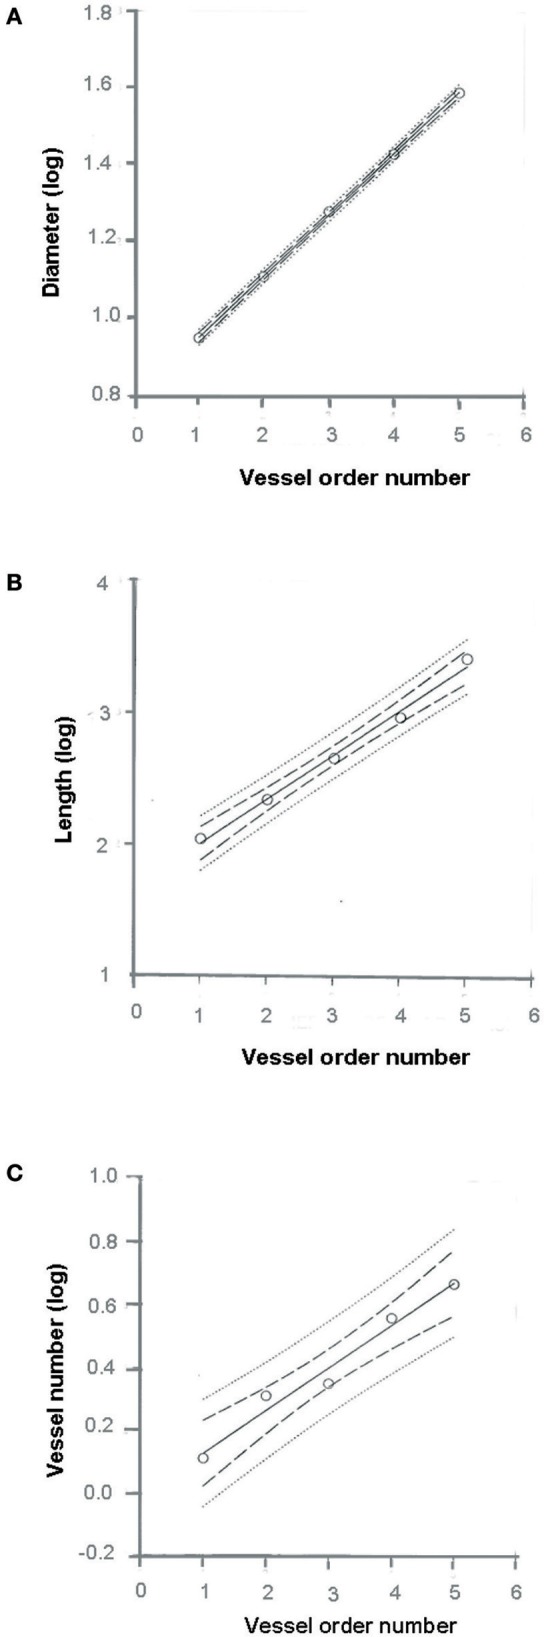
Relationships between mean diameter logarithm (A), length logarithm (B), logarithm of vessel element number in successive orders of vessels (C), and arteriolar order number. The multiple lines indicate confidence intervals.